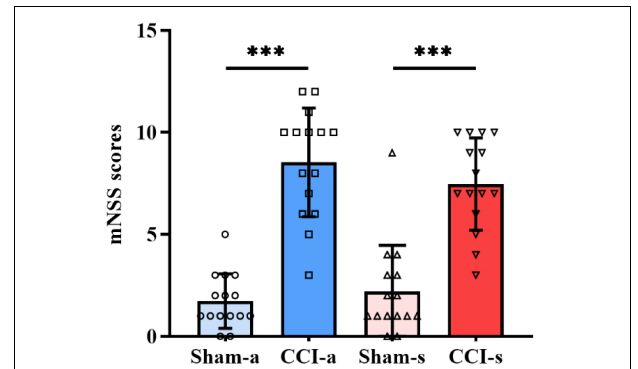
FIGURE 2 | Neurobehavioral scores on days 3 and 14 of TBI. The mNSS of Sham-a and CCI-a groups on day 3 of TBI (left two groups). The mNSS of Sham-s and CCI-s groups on day 14 of TBI (right two groups). N = 15; Data were expressed as mean ± SD; *** p <